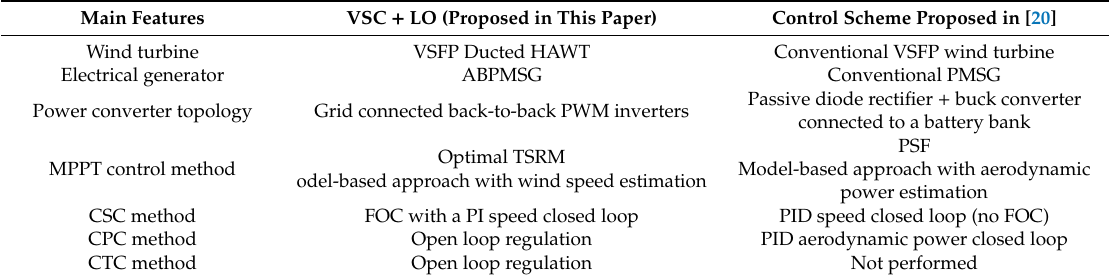
Table 6. Main features of the compared WECS control